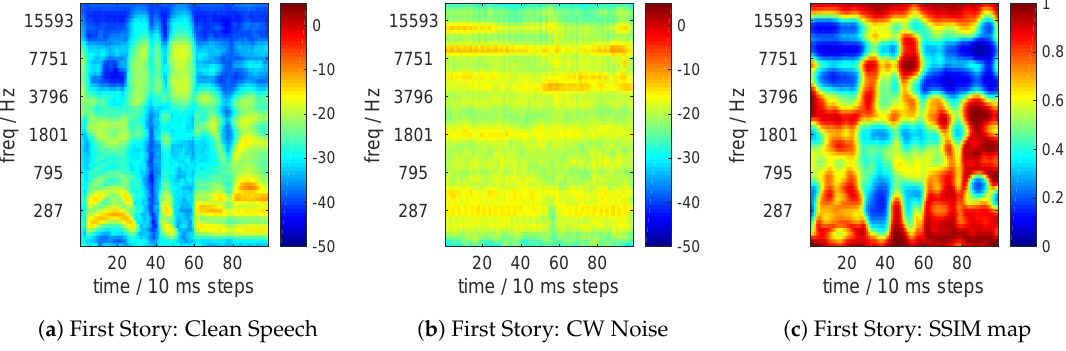
Figure 5. ( a ) The gammatonegram of one of the words uttered (and presented to the subjects in the experiments for the word spotting task) from the first story without any masker; ( b ) the gammatonegram of the masker (construction work noise) sound frame overlapping the word in ( a ); and ( c ) the SSIM map between the two gammatonegrams in ( a , b ). The Structural Similarity (SSIM) index is